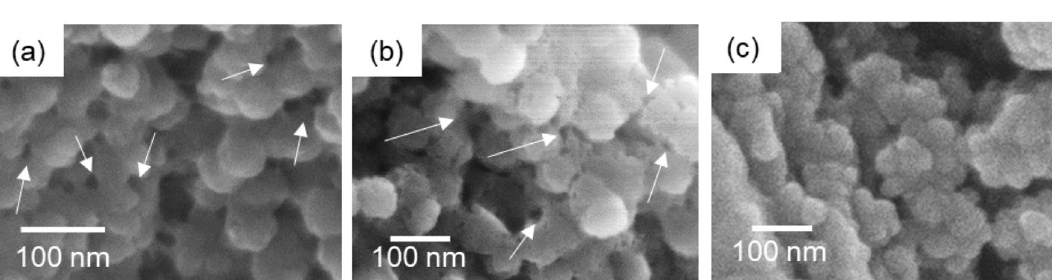
Figure 1. Characterization of the surface layer of a mature rice husk. A photo of a rice husk ( a ), SEM images of the surface ( b ), and the cross section ( c , e , h–l ) with elemental mapping ( d , f , g ) of a raw mature rice husk (Si: green; C: red; O: blue). White arrows indicate thin fibrils ( j ).